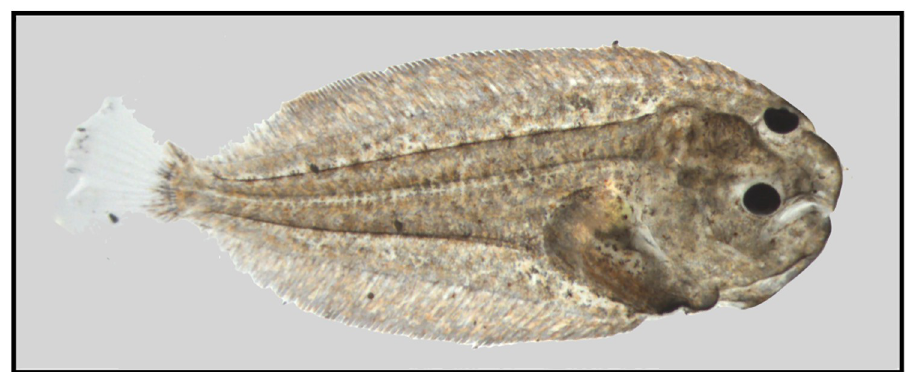
Fig 1. Fully metamorphosed Solea solea larva. A fully metamorphosed larva showing full asymmetrical body, rounded head and complete left eye migration.